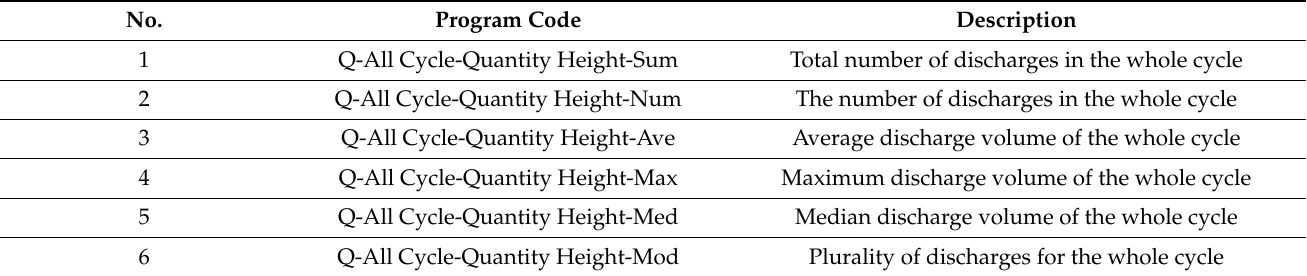
Table 1. Partial discharge characteristic parameters: basic discharge parameters.